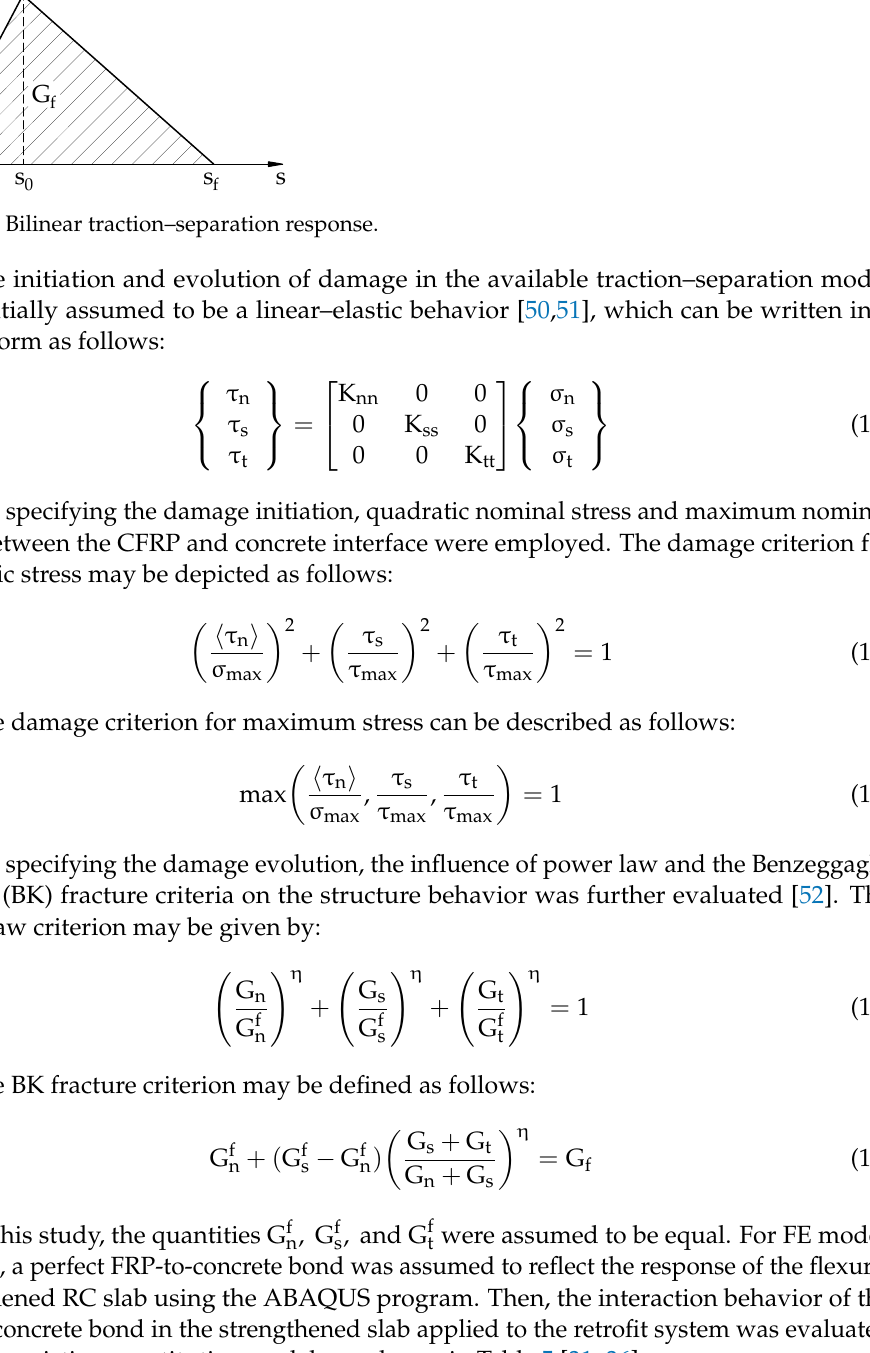
8 of 20 Figure 6. Concrete softening curve under uniaxial tension. Under uniaxial compression, a linear response is observed until reaching the initial value ( σ c0 ). In the plastic regime, the response is generally characterized by stress harden ‐ ing, followed by strain softening beyond the ultimate compressive stress [47]. 